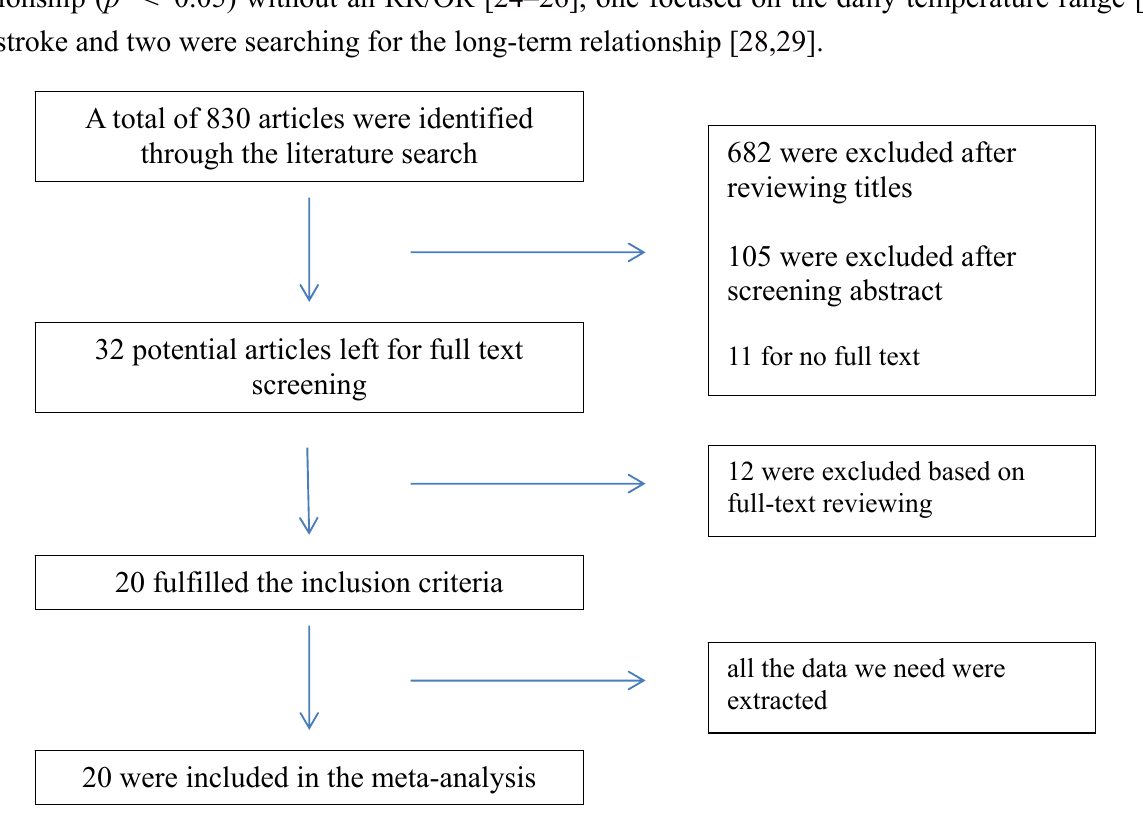
Figure 1. Flow chart of information through the different phases of a systematic